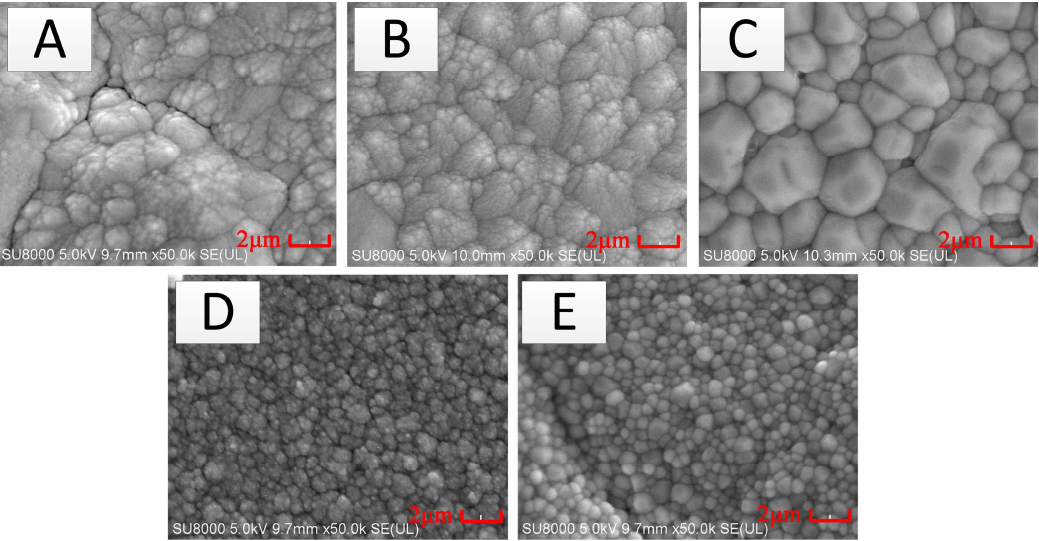
Figure 9. The SEM of In 2 O 3 films under different annealing processes. ( A : No annealing. B : 600 °C in air for 2 h. C : 1000 °C in air for 2 h. D : 600 °C with vacuum for 2 h. E : 1000 °C with vacuum for 2 h.).